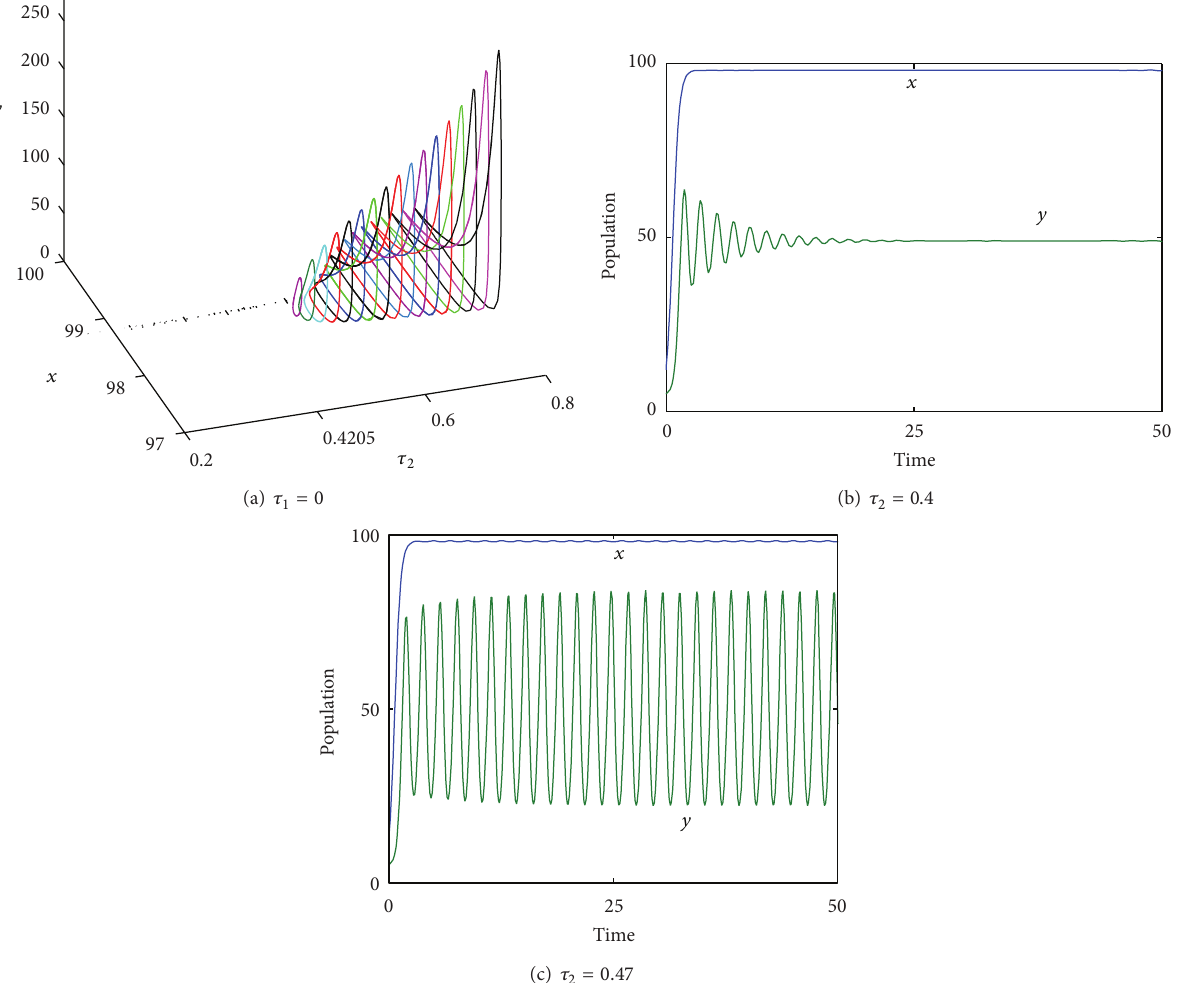
< 0.4205 , unstable for 2